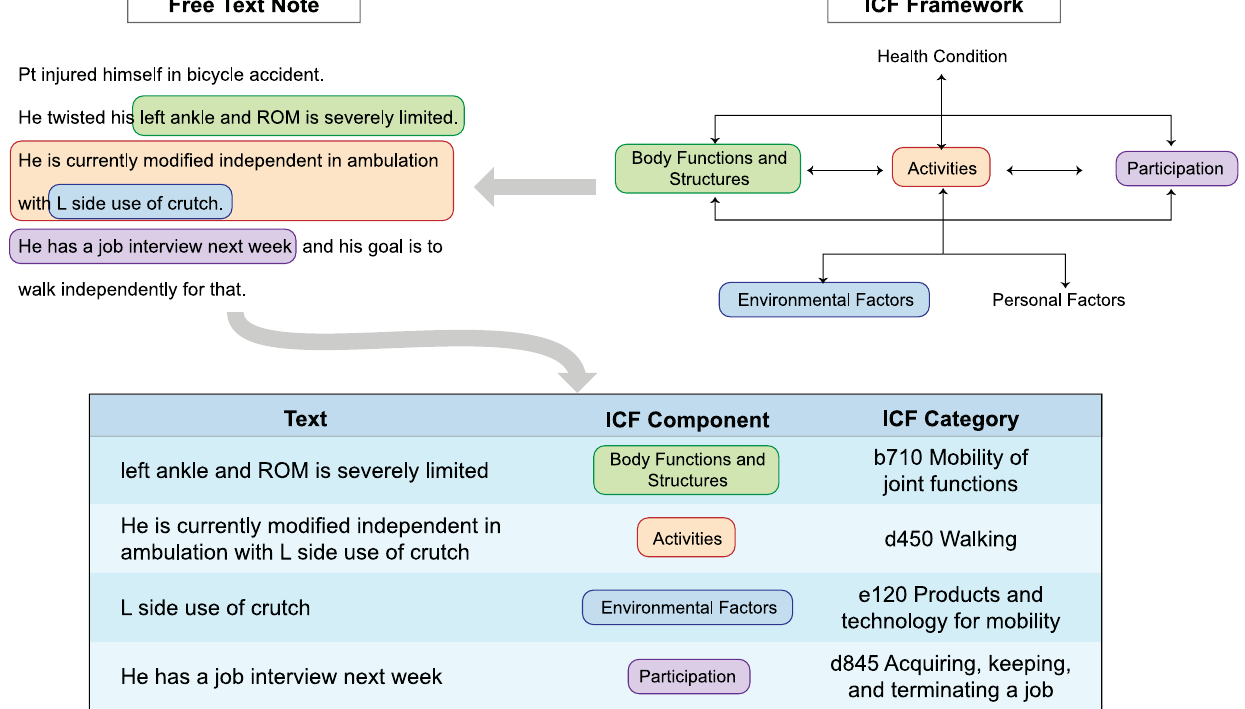
Fig 2. Examples of information related to different domains of the ICF in free text data. Diverse data, including information in free text, can be linked to standardized categories in the ICF classification, providing an internationally recognized conceptual structure for capturing multidimensional factors of patients’ functional experience. NLP technologies for information extraction and normalization can serve to perform this linking automatically, making free text observations accessible for analysis and insight. ICF, International Classification of Functioning, Disability and Health; NLP, natural language processing.